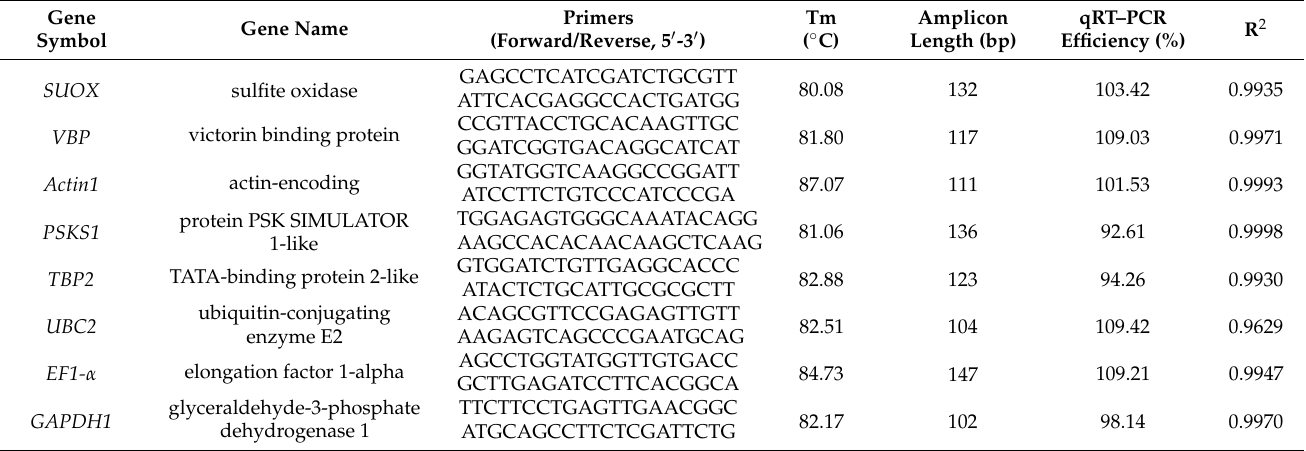
Table 1. Details of the primer sequences of candidate reference genes used in qRT–PCR analysis.